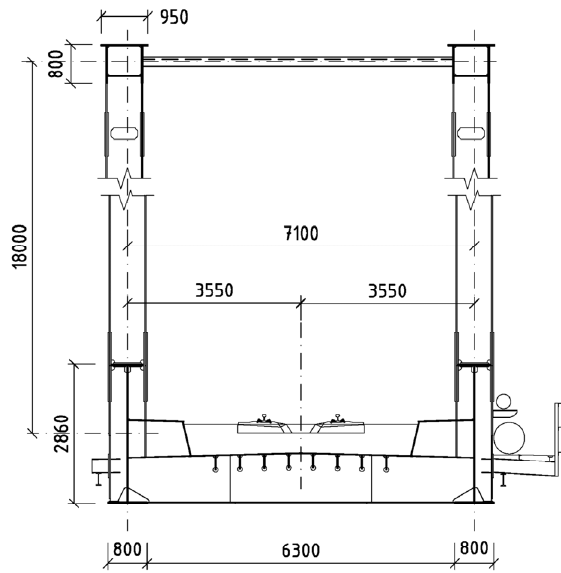
Figure 2. Cross-section of the right bridge superstructure in the middle of the span.